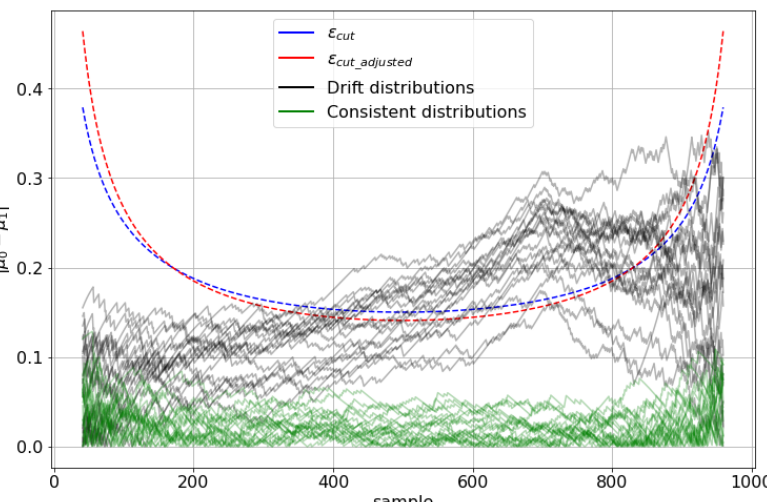
Figure 1. Simulated thresholds for 20 random Bernoulli distributions with no concept drift (consistent distributions, green) and with 20 drift mixed Bernoulli distributions (given in black). The drift point is at sample 700, where the probability parameter changes from 0.15 to 0.4. Drift is detected at the sample where the difference of the splits’ averages intersects the computed threshold (cid:101)